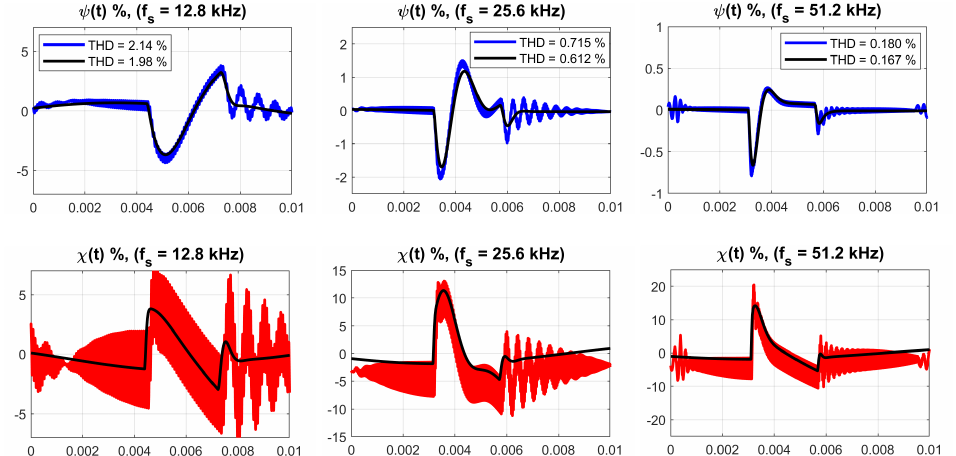
Figure 16. Effect of sampling on control performance. The black lines represent responses with the fictitious controller C ∗ ( s ) without any delay, and colored lines with the real controller C ( s ) optimized for THD. The higher the gain the lower the values of ψ ( t ) during the load period constituting the main contribution to THD. However, the still possible gain increase is restricted by oscillations of ψ ( t ) due to data processing delay important in the no-load